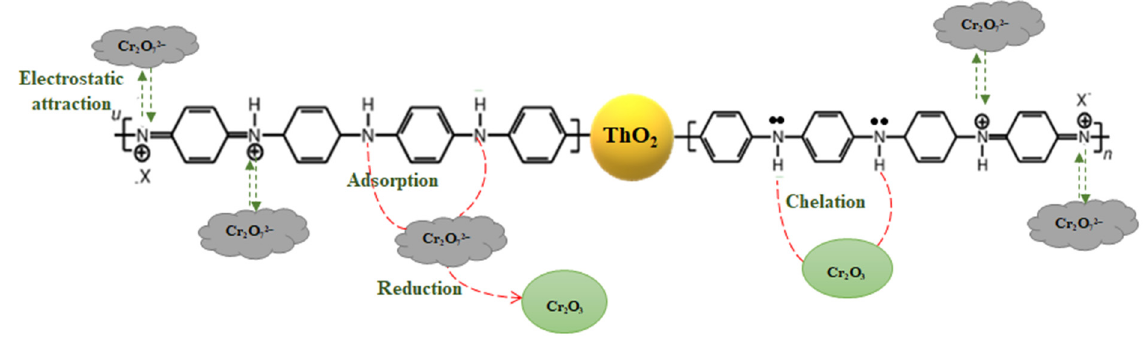
Figure 7. Proposed mechanism of Cr(VI) adsorption onto a ThO 2 -PANI